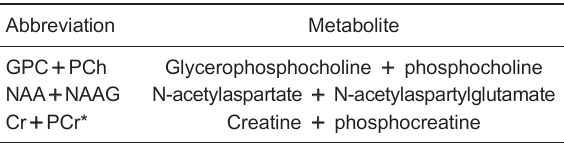
Table 2. Abbreviations and names of the metabolites evaluated in this